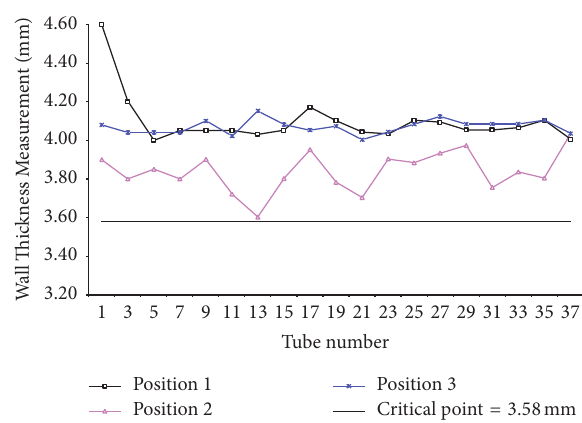
Figure 13: Thickness measurements of the platen superheater at zone